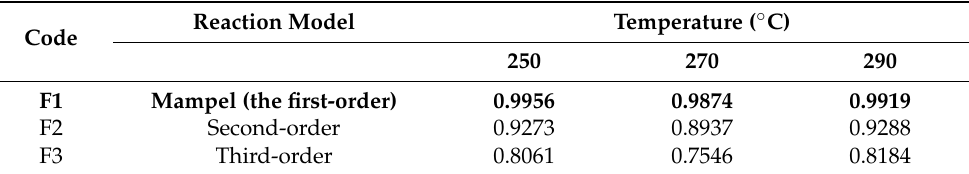
Table 2. Determination of the most probable mechanism of thermal decomposition based on the R 2 calculation.